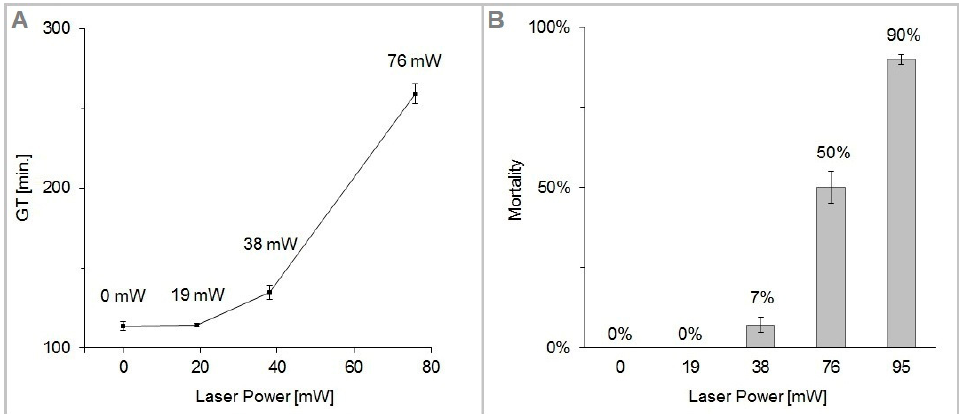
Figure 5. ( A ): Generation time ( GT ) of S. cerevisiae cells trapped for 15 min in optical tweezers with laser wavelength 1064 nm and trapping laser power P c in the range from 19 to 95 mW. The 0 mW point corresponds to the control unexposed cells; ( B ): mortality ( M ) of optically trapped S. cerevisiae cells under the experimental conditions identical to those in the generation time plot. On average, 13 samples were used for each data point. Error bars correspond to the standard error of the mean (SEM).